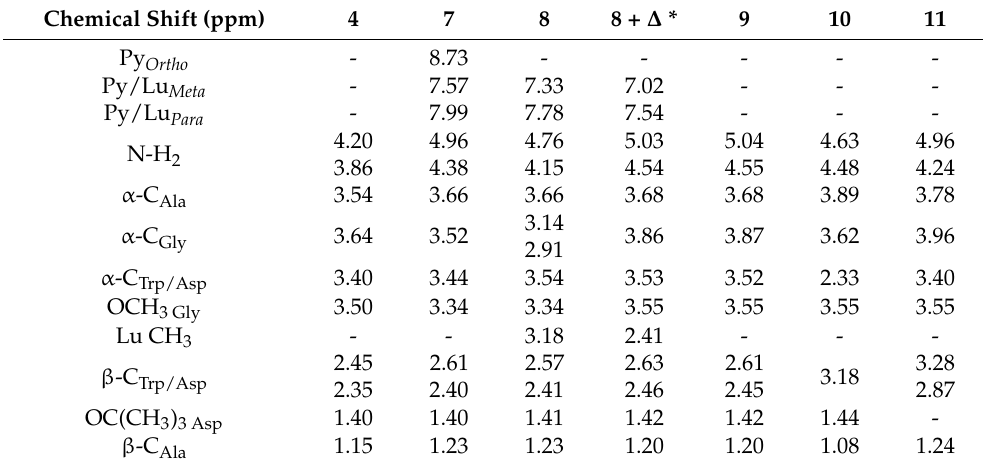
Table 2. Summary of 1 H NMR data: 4 = K[Pd( 1 )Cl], 7 = Pd( 1 )Py, 8 = Pd( 1 )Lu, 9 = Pd( 1 ), 10 = Pd( 2 ), 11 = Pd( 3 ).